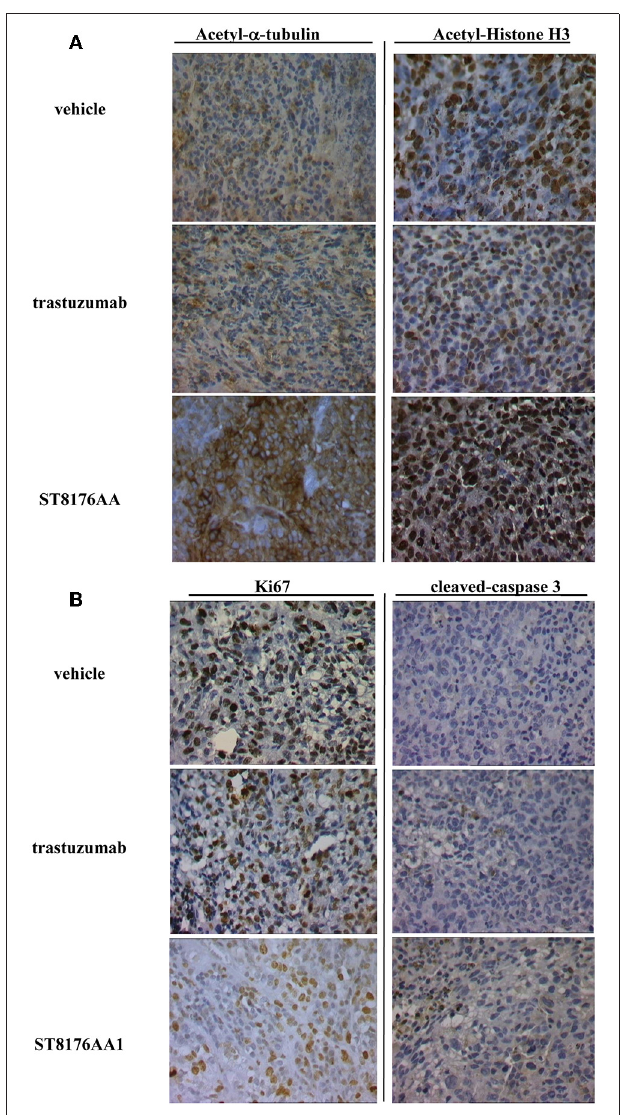
FIGURE 9 | Immunohistochemistry of tumor masses from SKOV3 xenografts. SKOV3 xenografts collected 24h after the last drug administration and analyzed by immunohistochemistry for the expression of acetylated- α -tubulin and acetylated-histone H3 (A) , or Ki67 and cleaved-caspase-3 (B) . Images captured using 40 × magnification. Scale bar: 500 µ m. One representative section, out of 6, for each group is